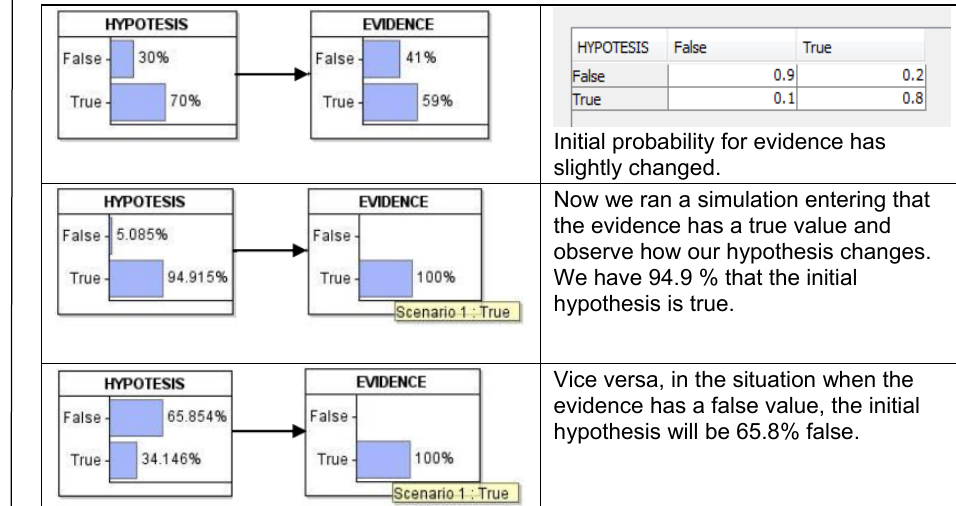
Table 2 – Propagation through the Bayesian